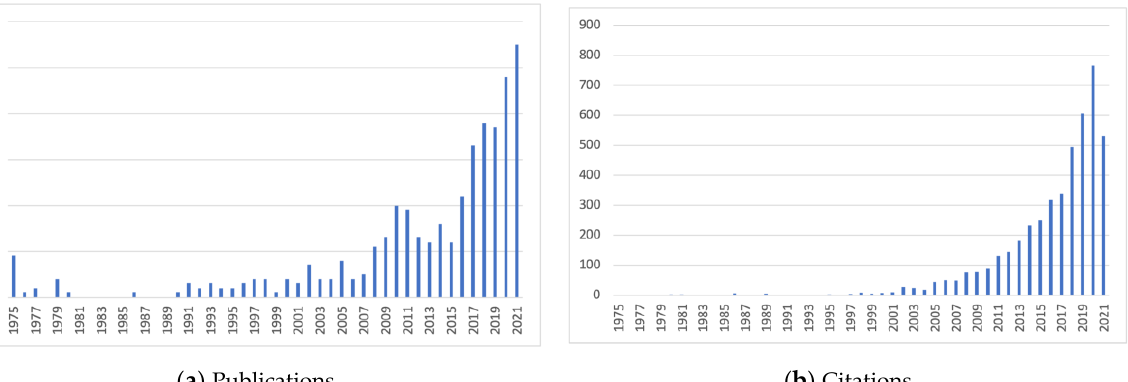
Figure 1. Dynamics on ( a ) publications and ( b ) citations in the field. Source: Authors’ selection from the WoS database, based on selected words and using Excel.